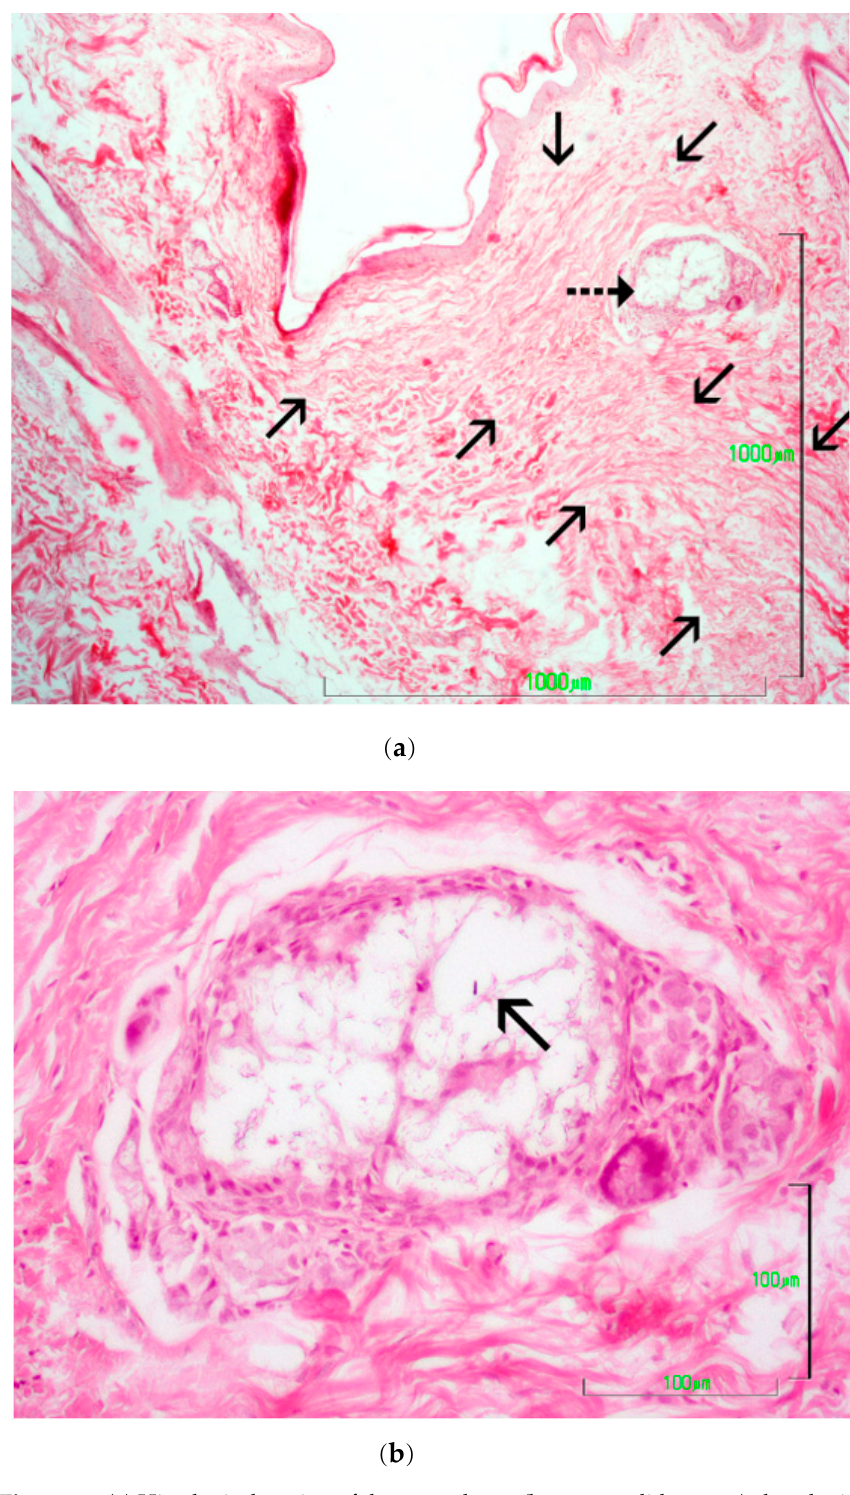
Figure 14. ( a ) Histological section of the wound area (between solid arrows) closed with glue on the 365th po.d. Small quantities of glue deposited below the epidermis (dotted arrow). ( b ) Close-up of the inclusion of glue (arrow) initiating inflammation.